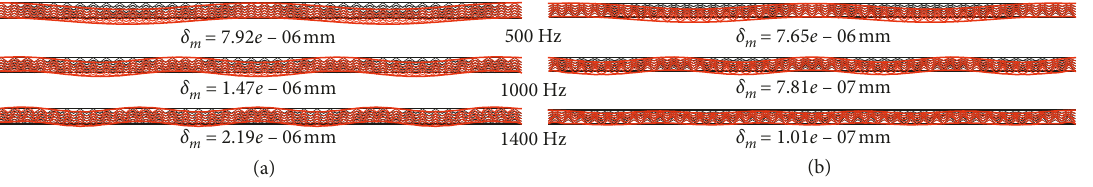
Figure 9: Vibrating deformations of the considered DAH sandwich models: (a) model 3 and (b) model 6 at 500, 1000, and 1400Hz, where δ m denotes the displacement magnitude of the middle bottom face sheet.